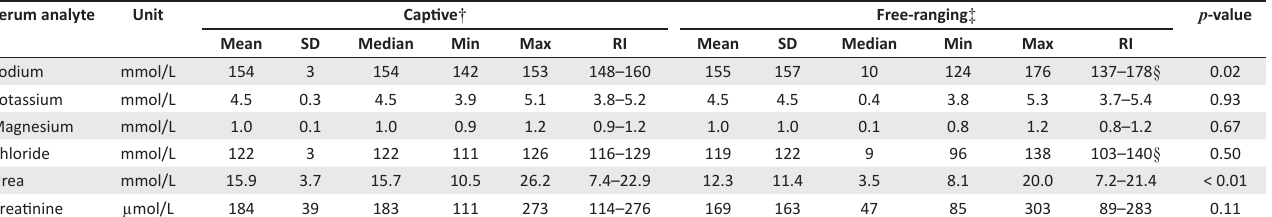
TABLE 4: Means, standard deviations, medians, minimum and maximum values, and reference intervals for serum analytes in captive and free-ranging Namibian cheetahs, using the Mann–Whitney U test. Serum analyte Unit Captive † Free-ranging ‡ p